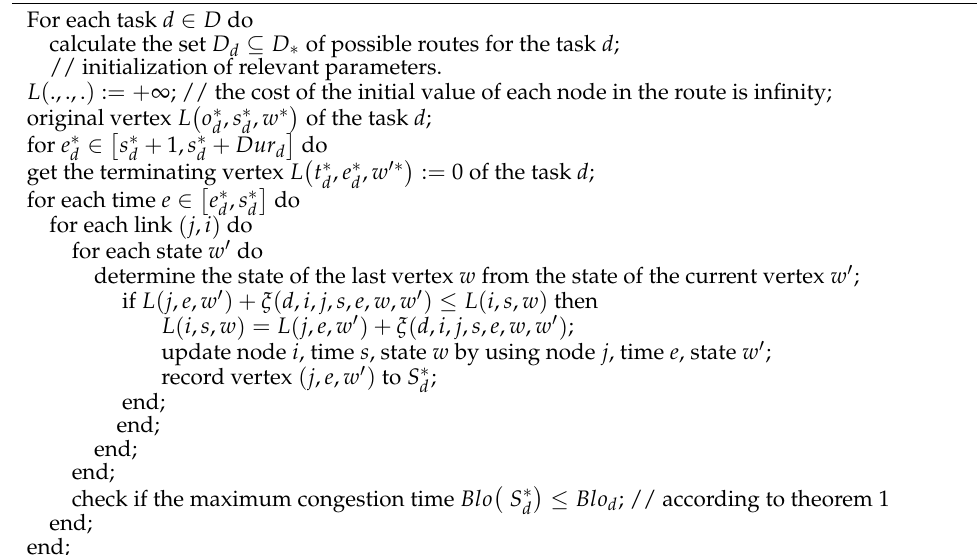
Algorithm 2. Dynamic programming